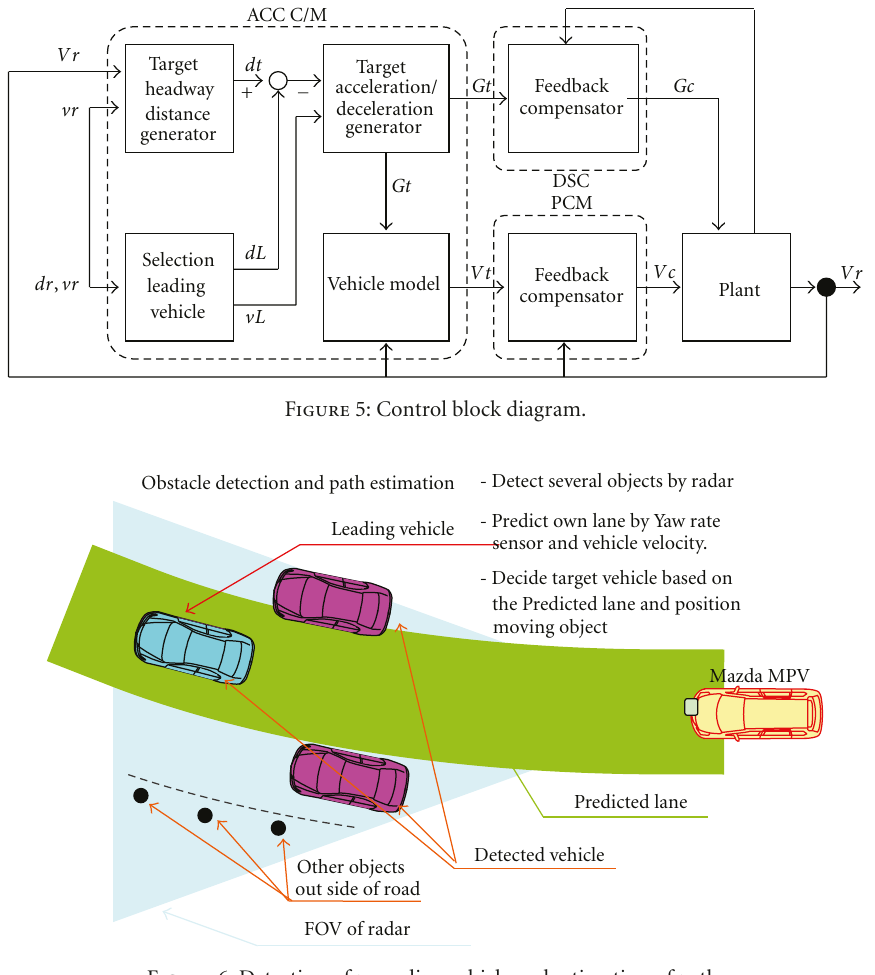
Figure 6: Detection of preceding vehicle and estimation of path.